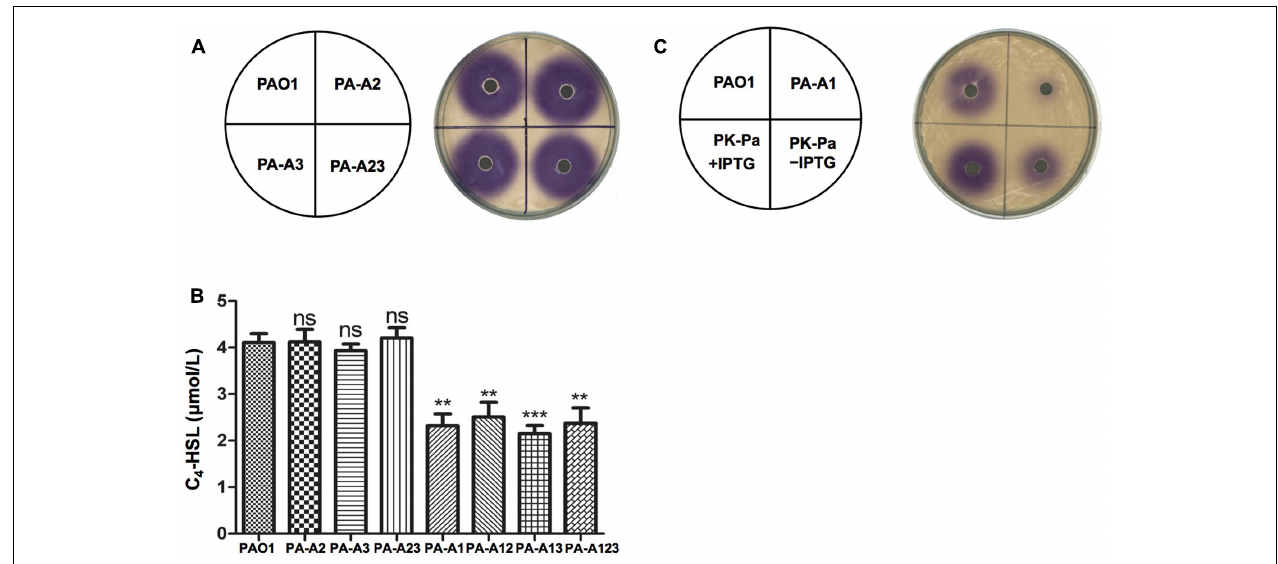
FIGURE 2 | Detection of C 4 -HSL signals produced by P. aeruginosa mutant strains. (A) Analysis of the C 4 -HSL signals produced by P. aeruginosa acpP2 and acpP3 mutant strains using Chromobacterium violaceum reporter strain CV026. (B) Quantitative analysis of the C 4 -HSL signal produced by P. aeruginosa acpPs mutant strains using high performance liquid chromatography (HPLC). (C) Analysis of the C 4 -HSL signals produced by P. aeruginosa acpP1 mutant strains using C. violaceum reporter strain CV026. The acylated HSL fraction was extracted from the supernatants of stationary-phase cultures grown in LB broth at 37 ◦ C for 12 h. PAO1, P. aeruginosa wild type strain; PA-A2, P. aeruginosa acpP2 ::Gm r single mutant strain; PA-A3, P. aeruginosa acpP3 ::Gm r single mutant strain; PA-A23, P. aeruginosa acp2 ::Tc r acp3 ::Gm r double mutant strain; PA-A1, P. aeruginosa acp1 ::Ec acpP single mutant strain; PA-A12, P. aeruginosa acp1 ::Ec acpP acp2 ::Gm r double mutant strain; PA-A13, P. aeruginosa acp1 ::Ec acpP acp3 ::Gm r double mutant strain; PA-A123, P. aeruginosa acp1:: Ec acpP acp2:: Tc r acp3:: Gm r triple mutant strain; PK-Pa, P. aeruginosa acp1 ::Ec acpP single mutant strain carrying plasmid, pSRKPa, encoding wild type P. aeruginosa acpP1 gene. Data are the mean ± standard deviation of triplicate measurements. Pair-wise comparisons were made between wild-type strain PAO1 and each mutant strain by Student’s t -test. ∗∗∗ Highly significant difference, P < 0.01. ∗∗ Significant difference, P < 0.05. ns, no significant difference, P >